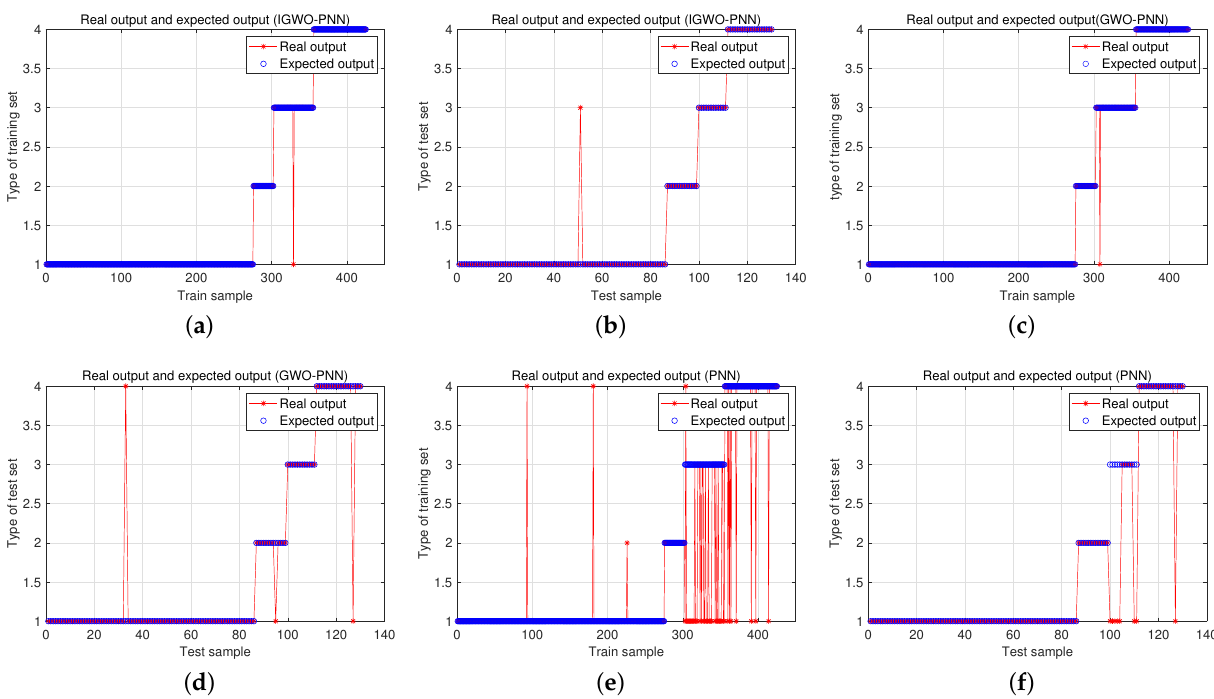
Figure 6. Comparison of the diagnosis results of the first set of comparative experiments. ( a , c , e ) represent the results of